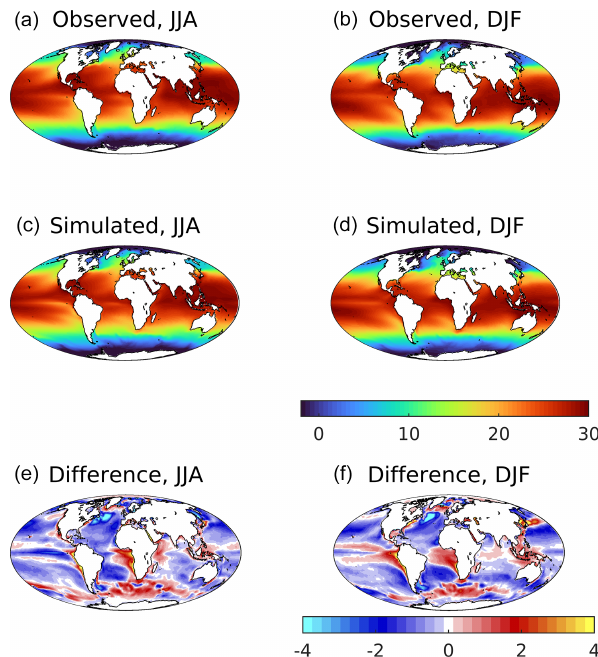
Figure 1. Observational ( a, b ; HadISST) and simulated (c, d) sea surface temperature for northern ( a, c, e ; JJA) and southern ( b, d, f ; DJF) summer. Differences (simulated–observed) for both seasons shown in (e, f) . Temperature (and difference in temperature) in ◦